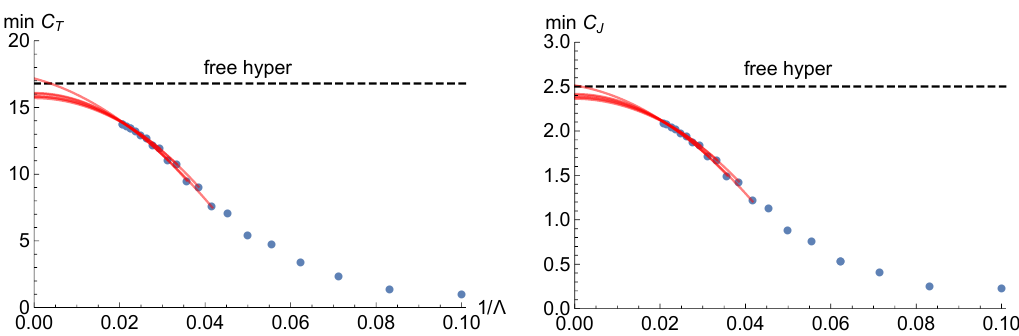
Figure 1 . The lower bounds on C T and C J at di(cid:11)erent derivative orders (cid:3), assuming SU(2) (cid:13)avor group and allowing higher spin conserved currents in the trivial or adjoint representation. Also shown are the values for a free hypermultiplet, C T = 84 extrapolations to (cid:3) ! 1 using the ansatz (8.2), for (cid:3) 2 4 Z and (cid:3) 2 4 Z + 2, separately.